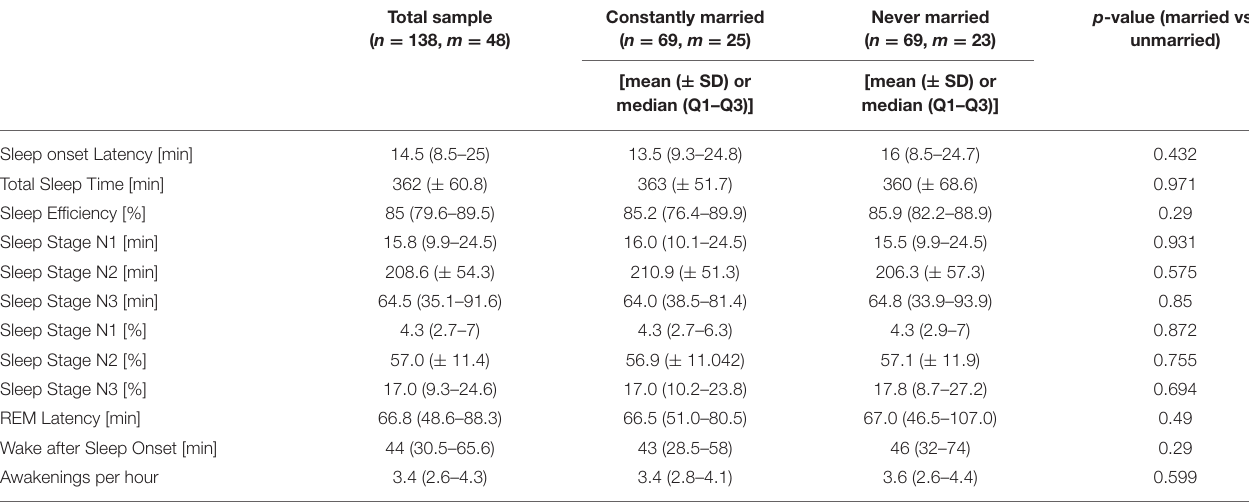
TABLE 2 | Polysomnographic sleep